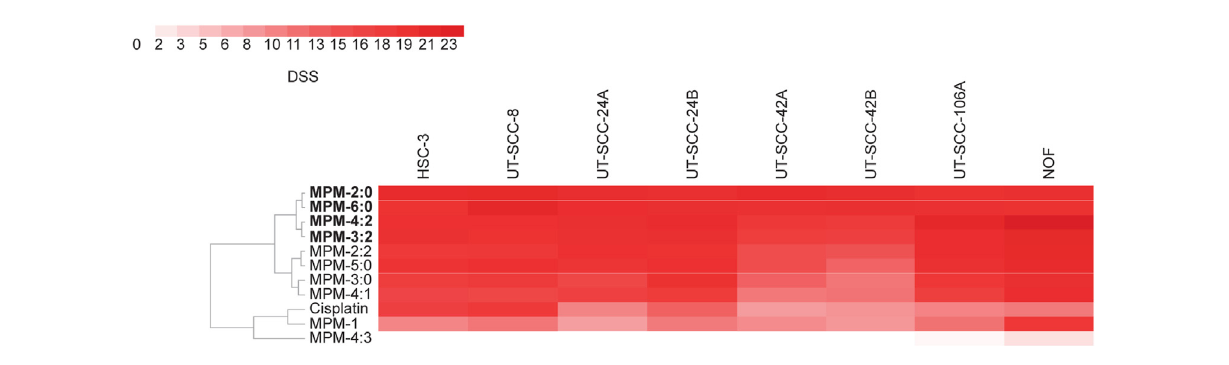
FIGURE 2 The potency of the MPMs was determined against a panel of seven head and neck squamous cell carcinoma cell lines as well as non-malignant normal oral fi broblasts (NOF) in a high throughput drug screening. The drug sensitivity scores (DSS) for each cell line and compound was calculated and presented as a heat map. The higher the DSS, the more potent the drug is. Exact DSS values are presented in Supplementary Table